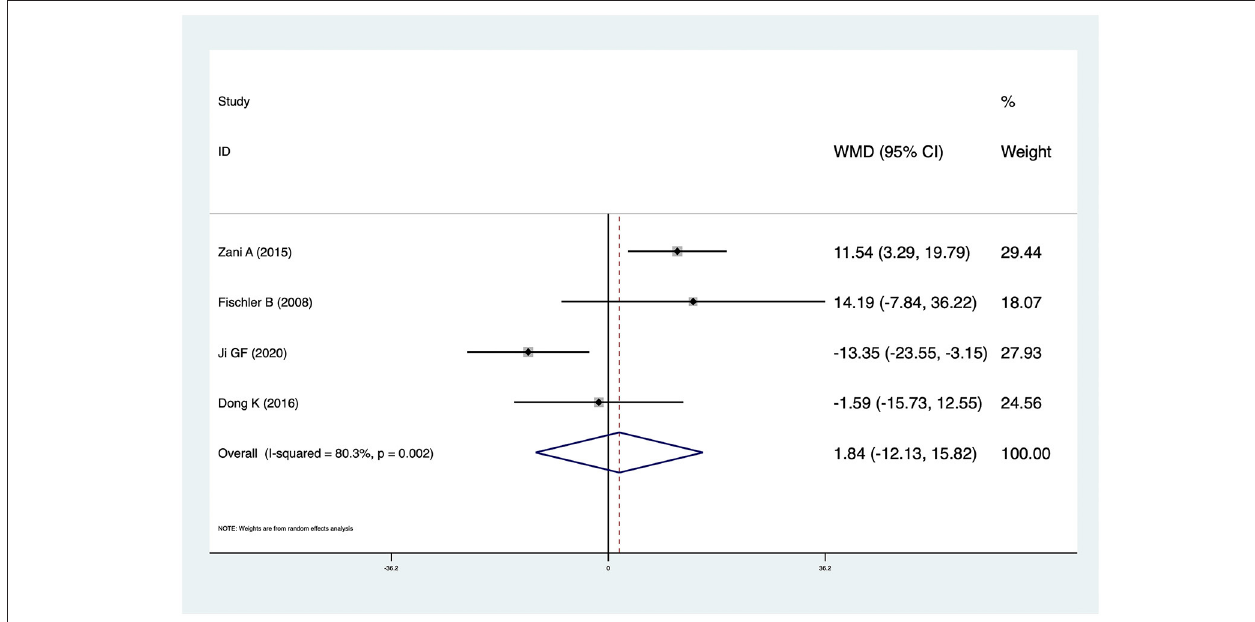
FIGURE 6 | Forest plot of the KPE time of CMV + BA vs. CMV − BA.